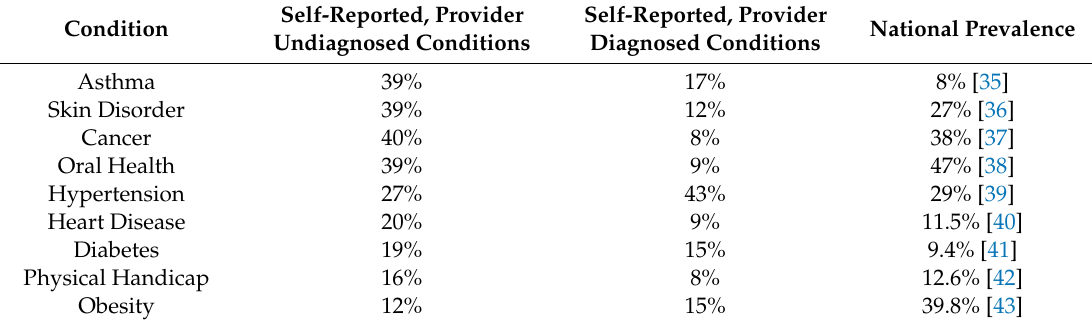
Table 1. Self-reported, provider undiagnosed and self-reported, provider-diagnosed conditions of the respondents are shown.